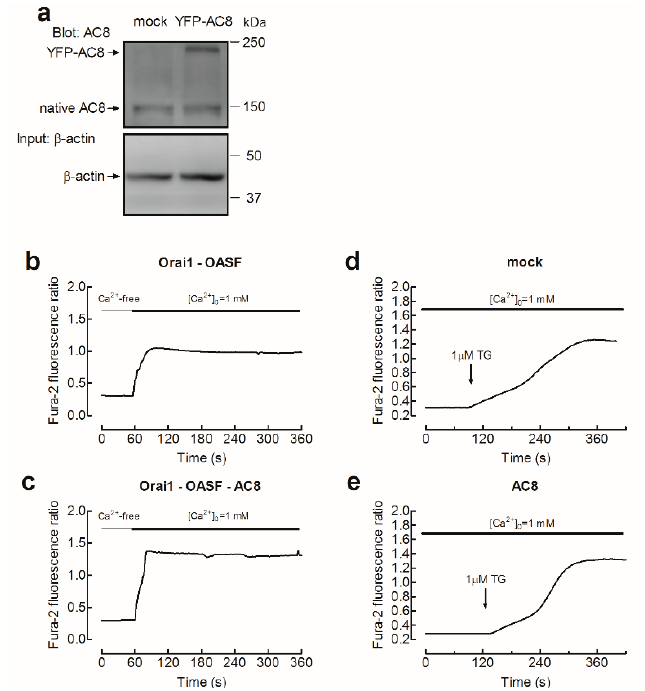
Figure 6. AC8 overexpression enhances store-operated Ca 2+ influx in MDA-MB-231 breast cancer cells. ( a ) MDA-MB-231 cells were transfected with YFP-AC8 transfection plasmid or empty vector (mock), as indicated. Forty-eight hours after transfection, cells were lysed and subjected to Western blotting with anti-AC8 antibody, followed by reprobing with anti- β -actin antibody for protein loading control. Molecular masses indicated on the right were determined using molecular-mass markers run in the same gel. ( b , c ) Cells were transfected with Orai1 and OASF plasmids, as well as either with YFP-AC8 plasmid ( c ) or empty vector ( b ), as indicated. Forty-eight hours after transfection, fura-2-loaded cells were perfused with a Ca 2+ -free medium (100 µM EGTA added), followed by reintroduction of external Ca 2+ (final concentration 1 mM) to initiate Ca 2+ entry. ( d , e ) Cells were transfected with YFP-AC8